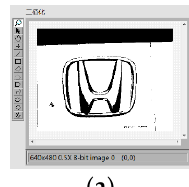
Figure 11. Binarization: ( a ) before and ( b ) after.